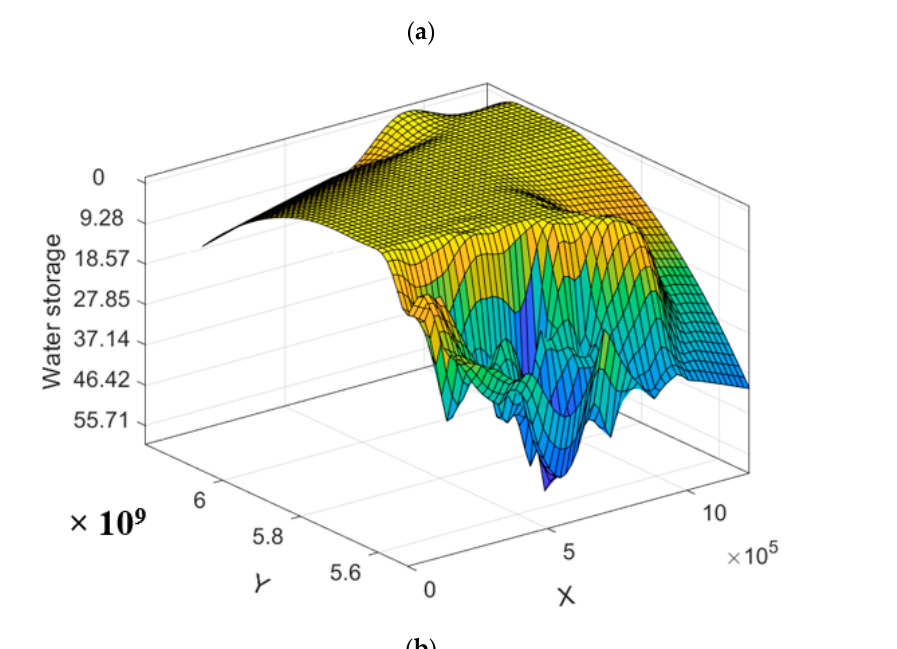
Figure 12. ( a ) Example of lower, upper, and normal storativity map calculated after SRBS, Paskapoo Formation. ( b ) Final storativity map for Paskapoo Formation.